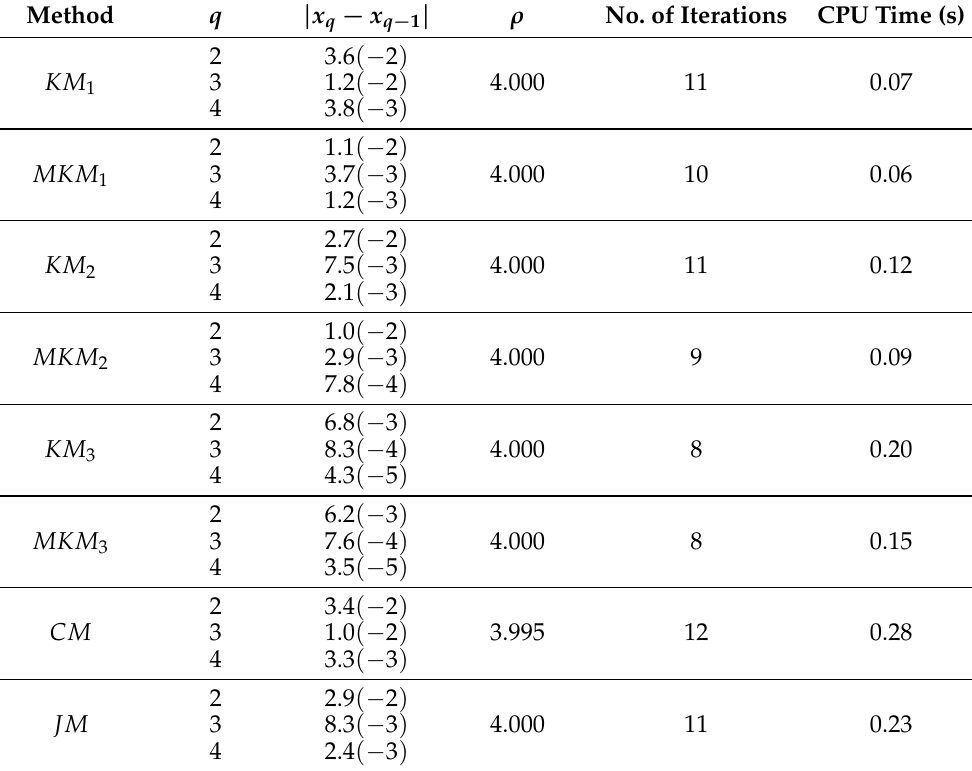
Table 3. Results of fluid permeability in bio gels with initial guess x 0 =